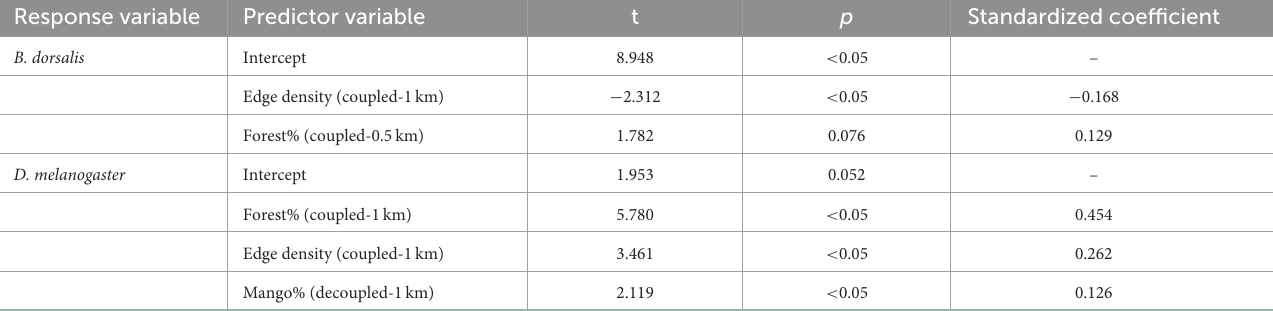
TABLE 2 Multiple linear regression screening of landscape heterogeneity variables explaining species variation integrating spatial coupled and